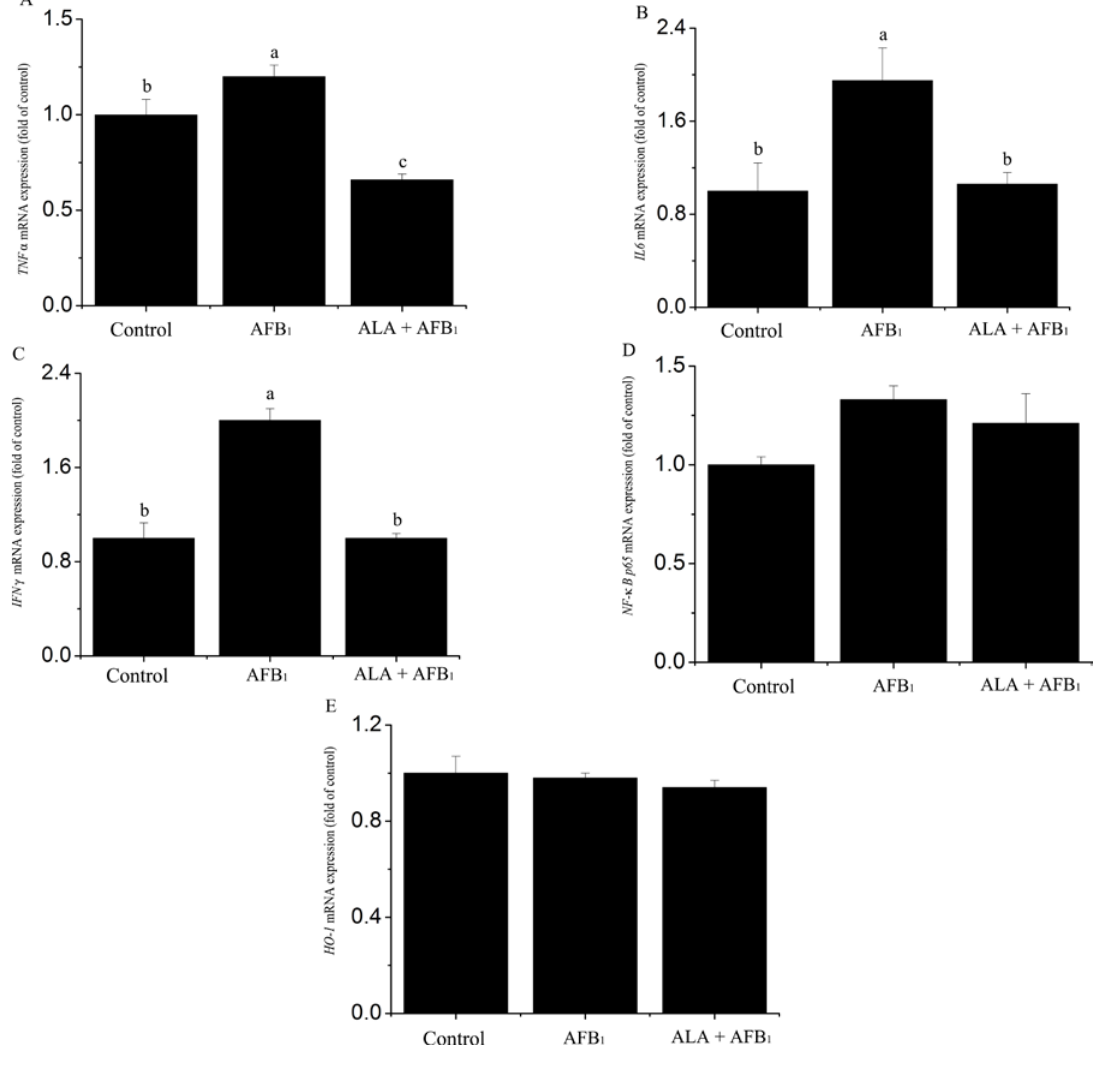
Figure 3. Effect of alpha-lipoic acid on inflammation-related genes of spleen in broilers fed a diet containing aflatoxin B (AFB ). ( A ) TNFα (tumor necrosis factor alpha); 1 1 ( B ) IL6 (interleukin 6); ( C ) IFNγ (interferon gamma); ( D ) NF-κB p65 (nuclear factor-κB p65); and ( E ) HO-1 (Heme oxygenase-1). ( n = 6). a,b,c Means with different letters are significantly different, p <